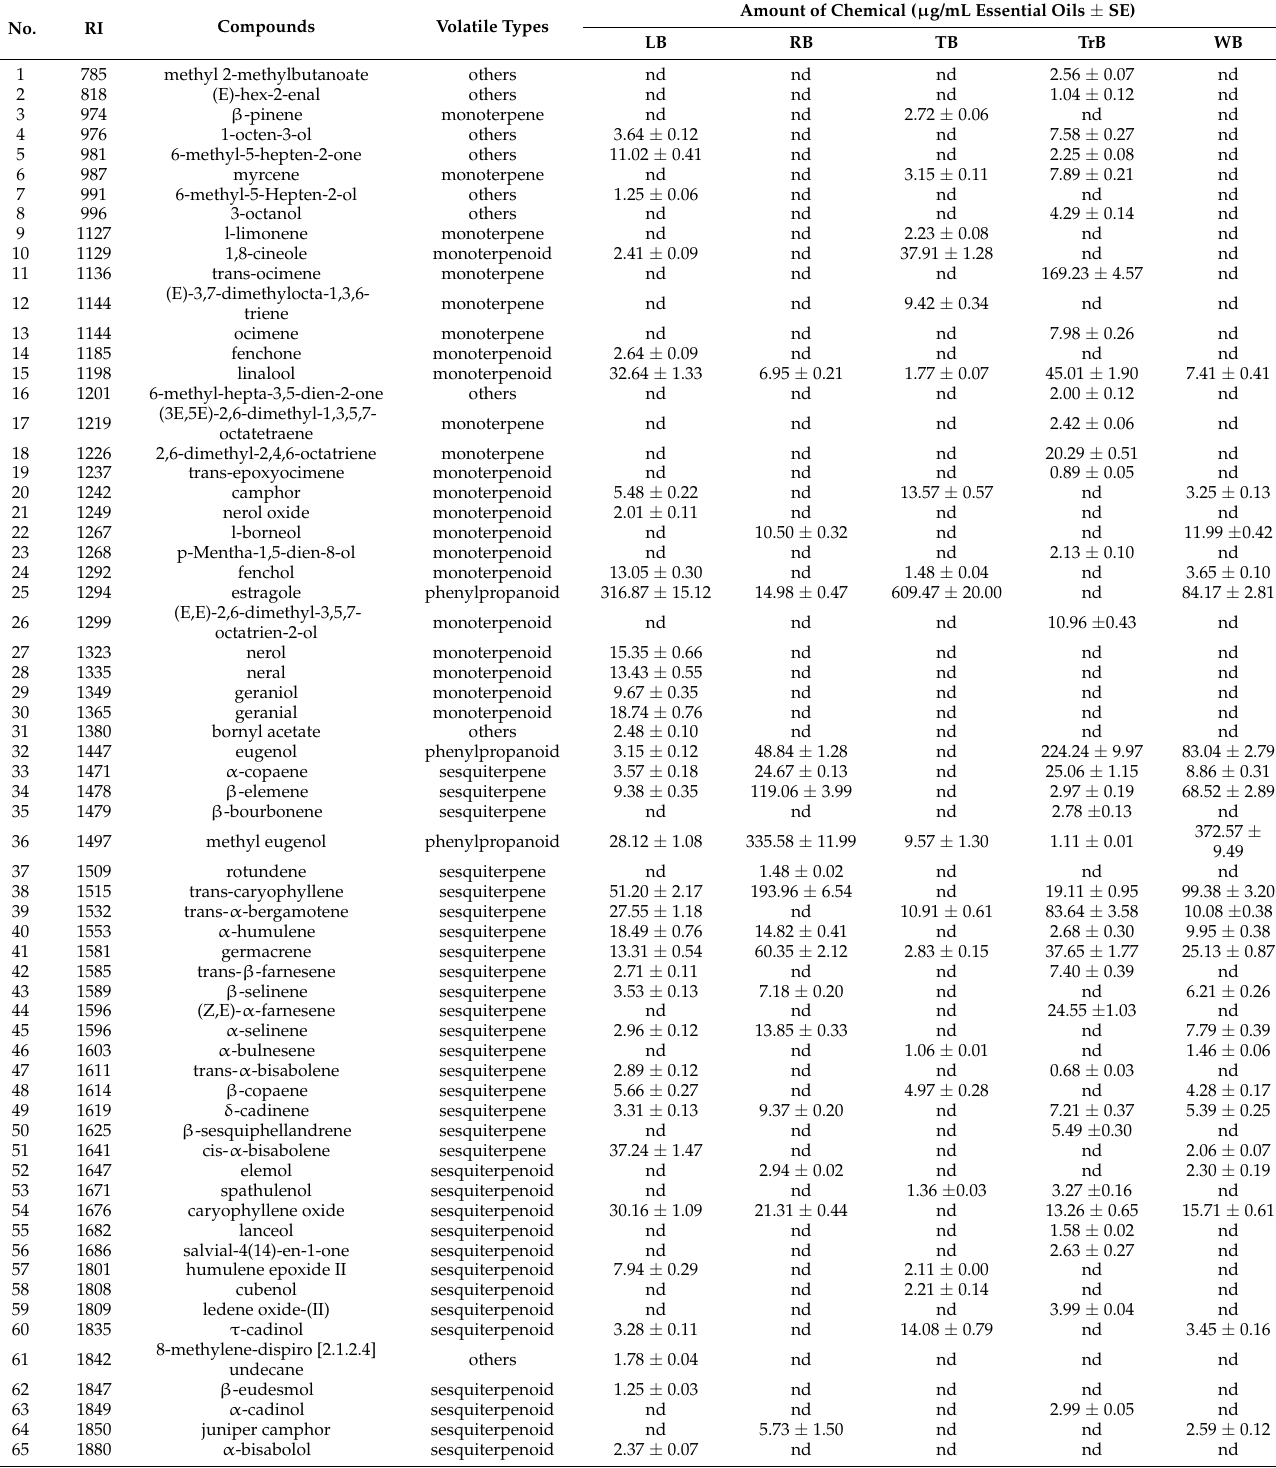
Table 2. Chemical compositions of the essential oils from five Ocimum spp.